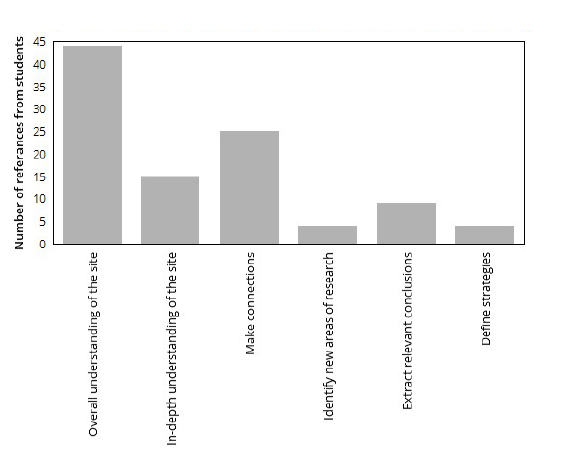
Figure 10. EIMS contribution for Phase 1 of the design process Figure 11. Was the EIMS framework/layer analysis